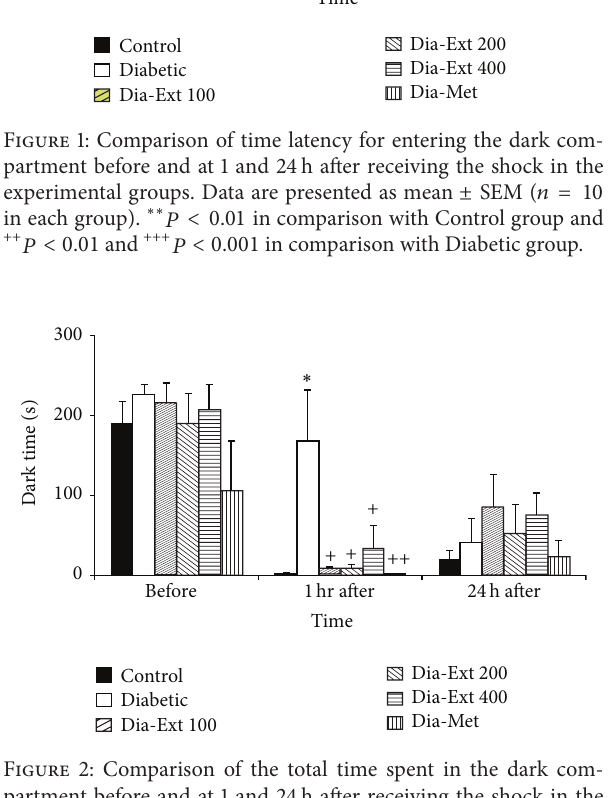
Figure 2: Comparison of the total time spent in the dark com- partment before and at 1 and 24 h after receiving the shock in the experimental groups. Data are presented as mean ± SEM ( 𝑛 = 10 in each group). ∗ 𝑃 < 0.05 in comparison with Control group and + 𝑃 < 0.05 and ++ 𝑃 < 0.01 in comparison with Diabetic group.